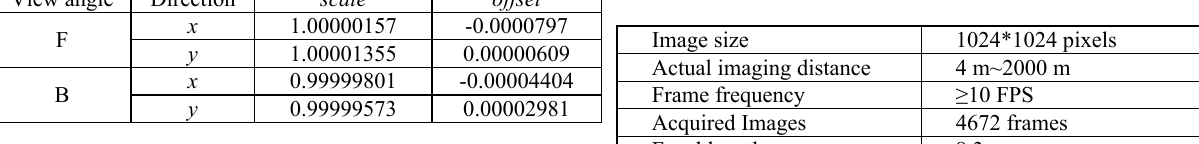
Figure 4. Imaging process of CE-3 descent camera Table 7.Technical parameters of CE-3 descent